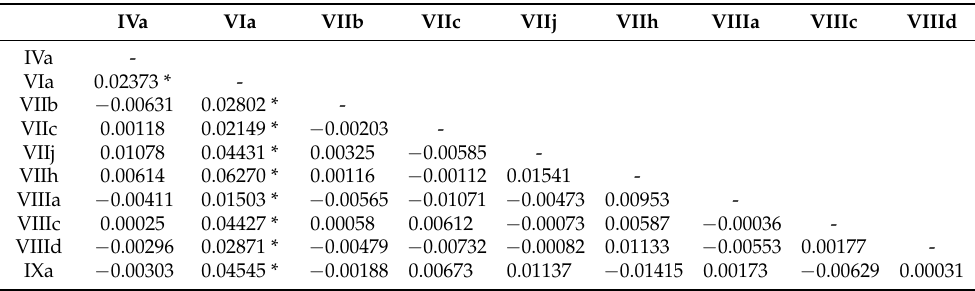
Table 4. Population pairwise F st values from mtDNA cox2 sequences among A. simplex from 10 fishing divisions. * significant value (significance level